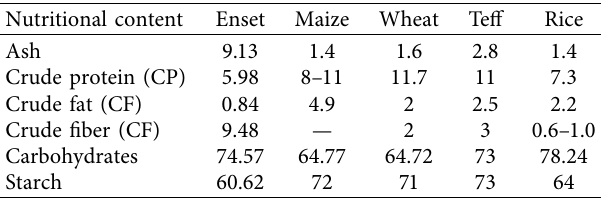
Table 3: Nutritional composition of Enset crop grain compared to maize, wheat teff, and